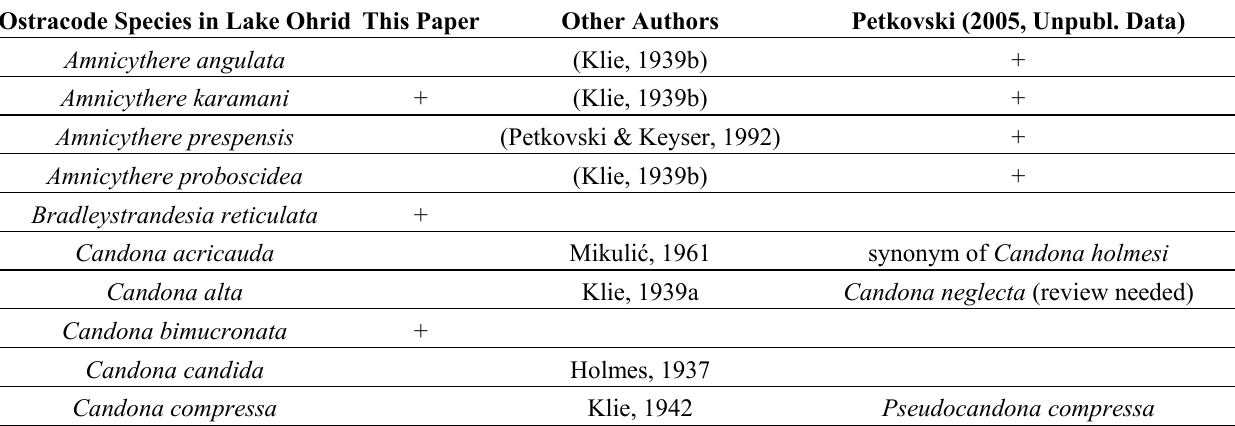
Table 1. Checklist of ostracode species from Lake Ohrid, including synonymy. Comparison with the ostracode fauna reported in this paper and by [30] (+living species, * valves or empty carapaces), species reported previously in the lake from other authors, and Petkovski (2005, unpubl.